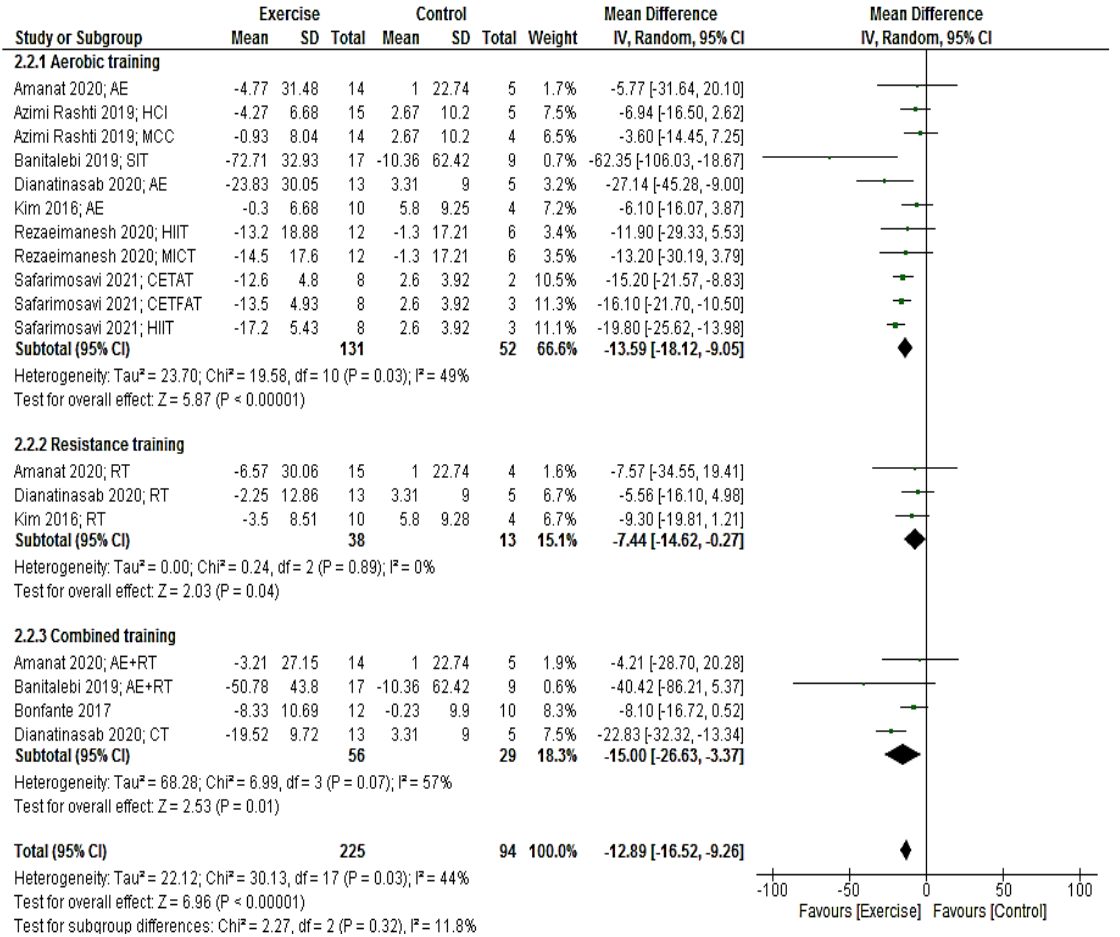
Figure 4: Forest plot of the effects of exercise training versus control on glucose. AE, aerobic; RT, re- sistance training; SIT, sprint interval training; HIIT. High intensity interval training; CETFAT, continuous endurance training with intensity equivalent to Fatmax (maximal fat oxidation); CETAT, continuous endurance training with intensity equivalent to anaerobic